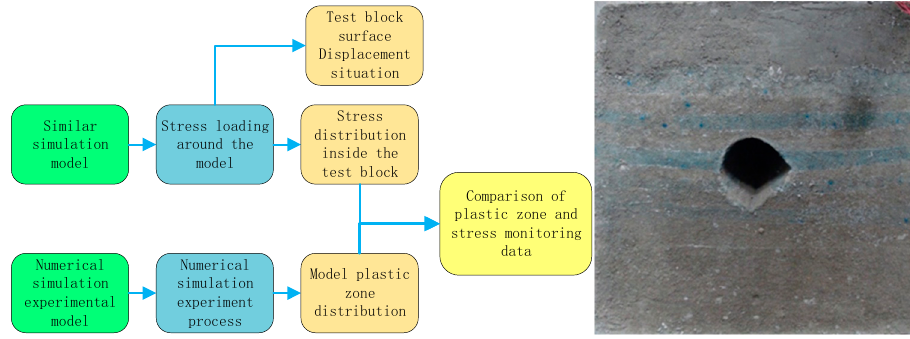
Figure 1. The experimental procedure and experimental model.